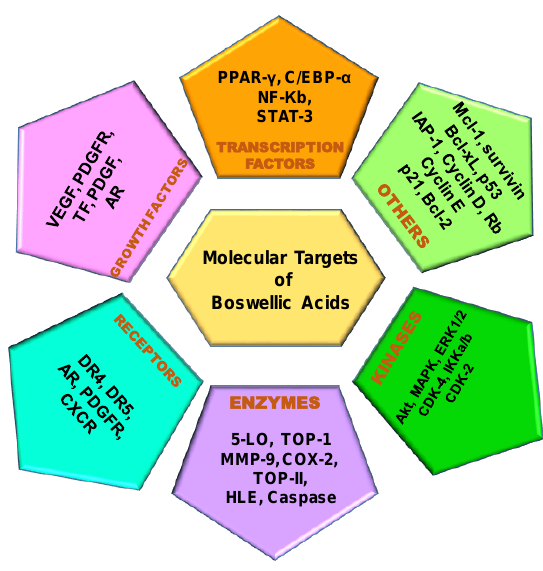
Figure 3. Molecular targets of Boswellic Acids and their analogues.